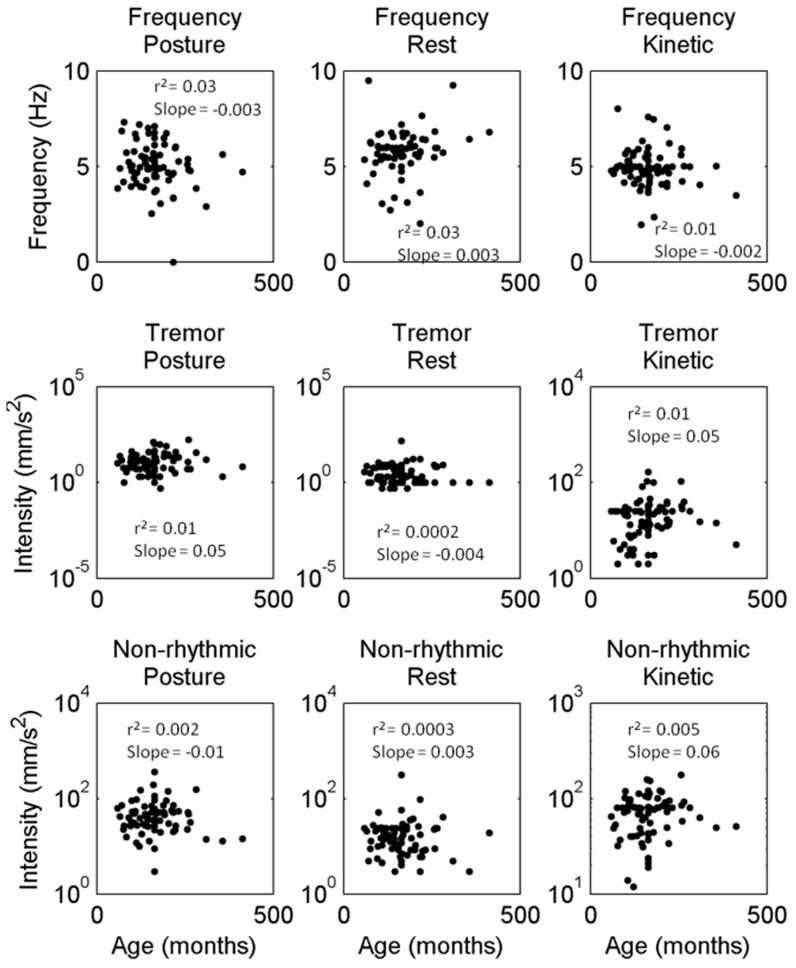
Correlation of frequency, tremor and non-rhythmic movement amplitude during postural, resting, and kinetic condition with subject’s age.Frequency, tremor and non-rhythmic movements during postural, resting, and kinetic conditions are plotted versus the subjects’ age in months. Slope and correlation coefficient by linear regression are depicted in the inset of each subplot. None of these parameters revealed any correlation.